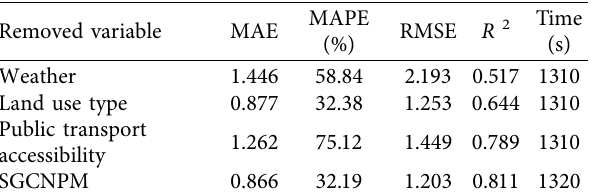
Table 6: Result comparison of removing any variable (after re- moving the data during